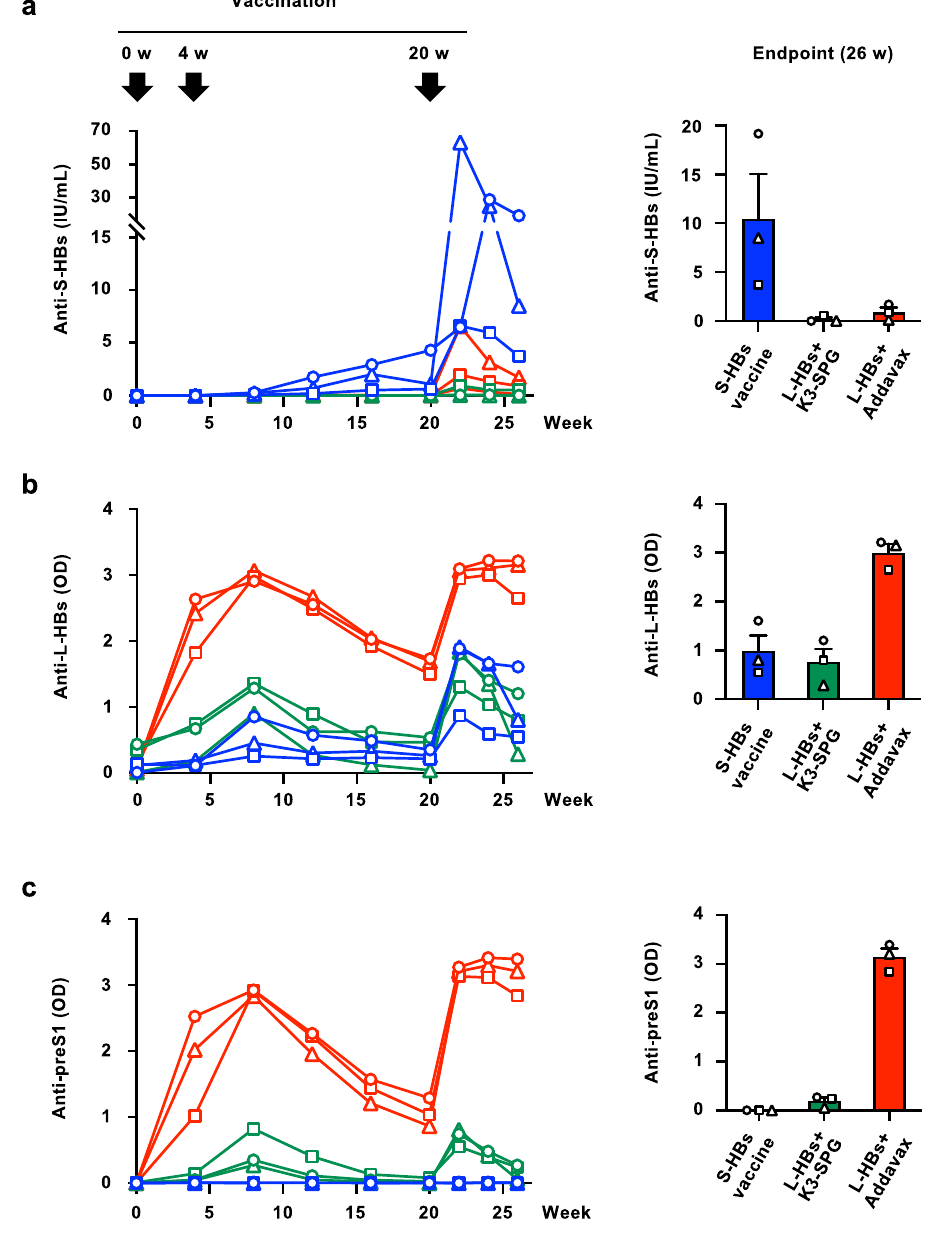
Fig. 1 | Immunization schedule of HB vaccines and induction of anti-HBs anti- bodies. The induction of antibodies to S-HBs ( a ), L-HBs ( b ), and preS1 ( c ) was measuredafterimmunizationofrhesusmacaqueswithS-HBsvaccine(blue),L-HBs +K3-SPG(green),orL-HBs+Addavax(red).Thesevaccineswereadministeredthree times subcutaneously at 0, 4, and 20 weeks, and the observation was continued until 26 weeks after the initial vaccination. Blood samples were collected every 4 weeks during the vaccination and every 2 weeks after the last vaccination. a The